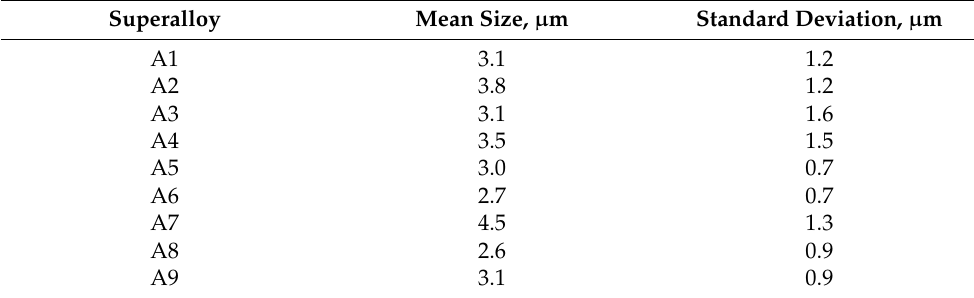
Table 4. Mean size of the MC carbides in A1–A9 superalloy castings.